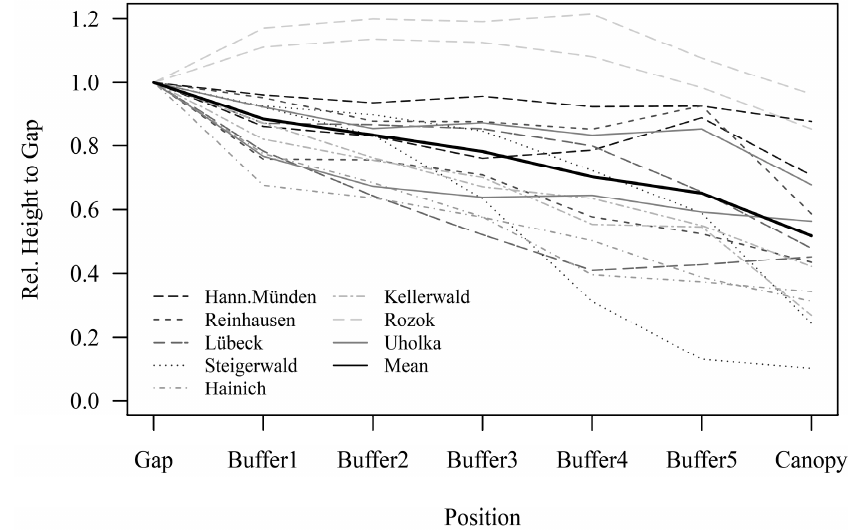
Figure 7. The different lines illustrate the mean height development of the regeneration relative to height in gap measured for seven classes; Gap = heights within the gap polygon; Buffer 1–5 = subsequent 1 m buffer zones around the gap polygon; Canopy = all remaining heights under the canopy. Each line represents one of the 16 study plots; the solid black line shows the mean height decrease of all plots together.